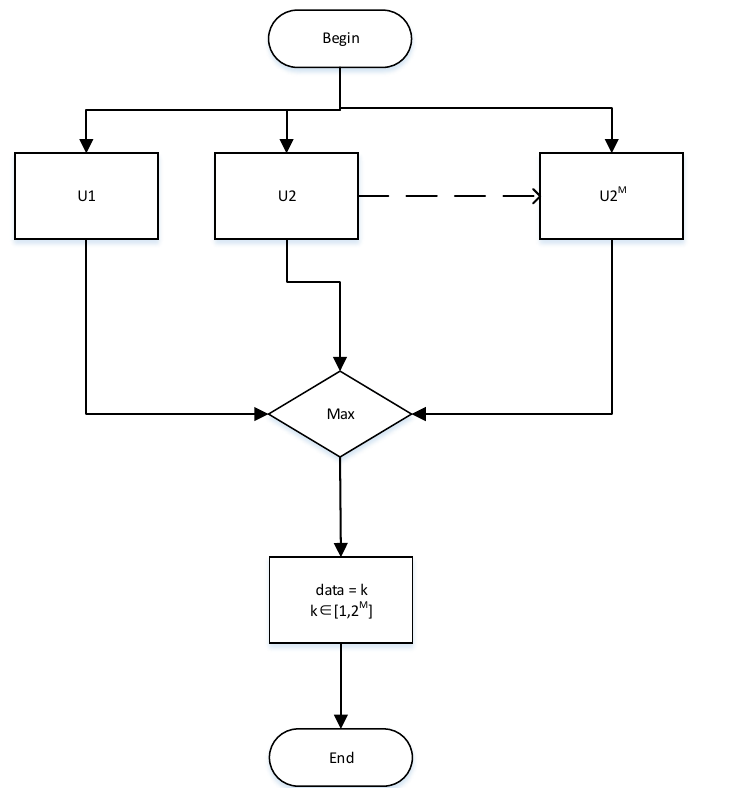
Figure 3. Symbol decision flow of optimal